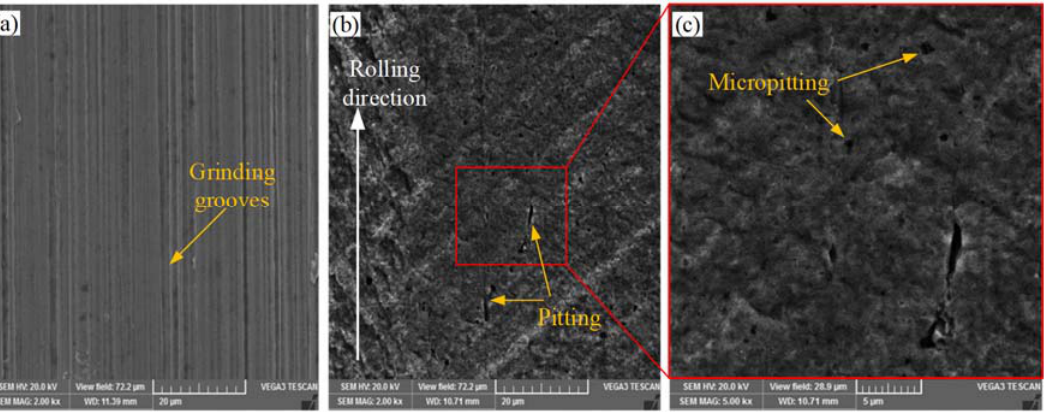
Figure 3. The SEM micrographs of the eccentric cylindrical surface of the crankshaft: ( a ) surface of new parts; ( b , c ) surface after failure.